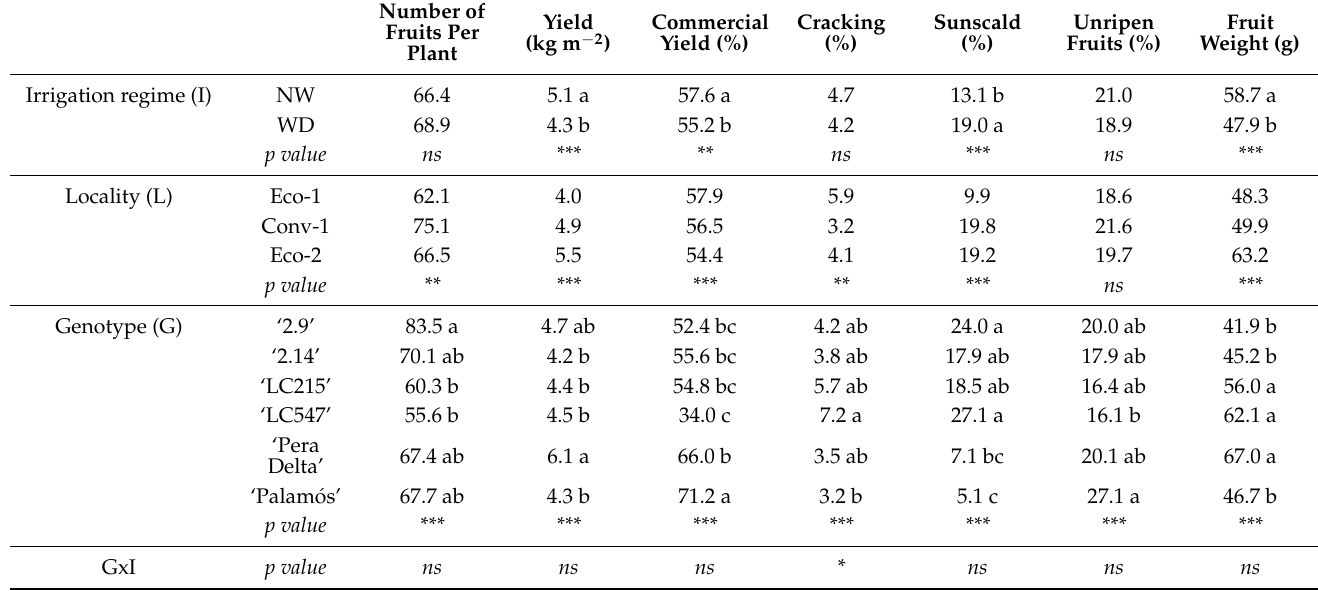
Table 2. Effect of irrigation regime (I), genotype (G) and locality (L) on agronomic performance. The level of significance is reported following * p < 0.05; ** p < 0.01; *** p < 0.001; ns, not significant ( p > 0.05). Within columns and for each fixed factor (I, G) different letters indicate significant differences according to Tukey multiple-range test ( p < 0.05). NW, normal watering; WD, water deficit. Blossom end rot (BER) was absent (<2%) and is not shown in this table. Genotypes: 2.9 and 2.14, Penjar breeding lines; LC215 (Penjar)